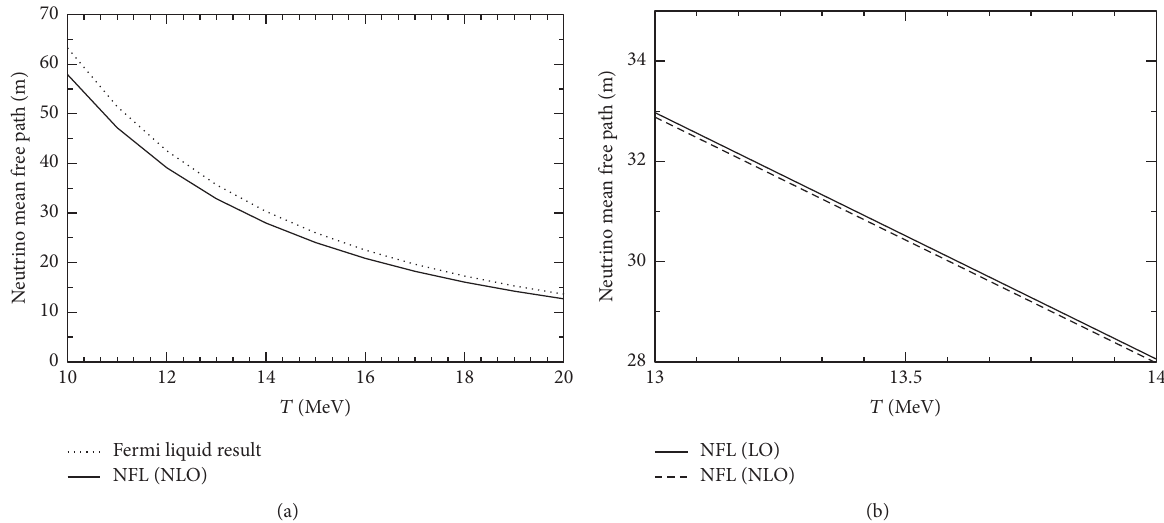
Figure 2: Mean free path of nondegenerate neutrinos. A comparison between the FL result and NLO corrections for the NFL effects has been presented in (a). The reduction of the MFP due to NLO corrections has been shown in